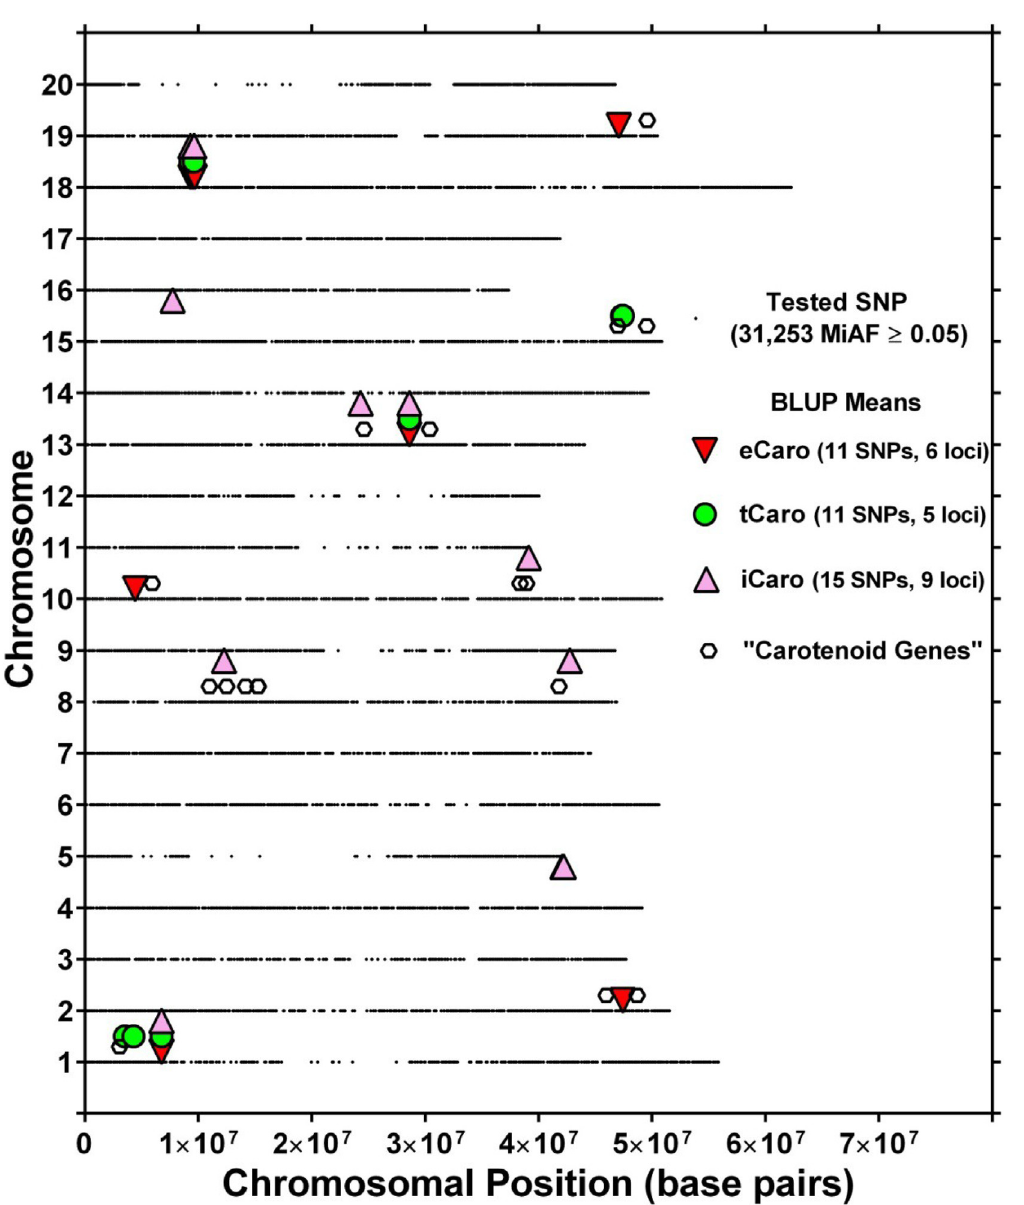
Fig 4. Location of putative loci significantly associated with carotenoids (eCaro, tCaro and iCaro) using MLM+Q+K model and carotenoid-related genes identified in Soybase. For each chromosome, the black dots represent the location of a SNP evaluated. Putative “ carotenoid genes ” were identified using the search term “ carotenoid ” in Soybase (www.soybase.org) and were located within ± 3MB of putative